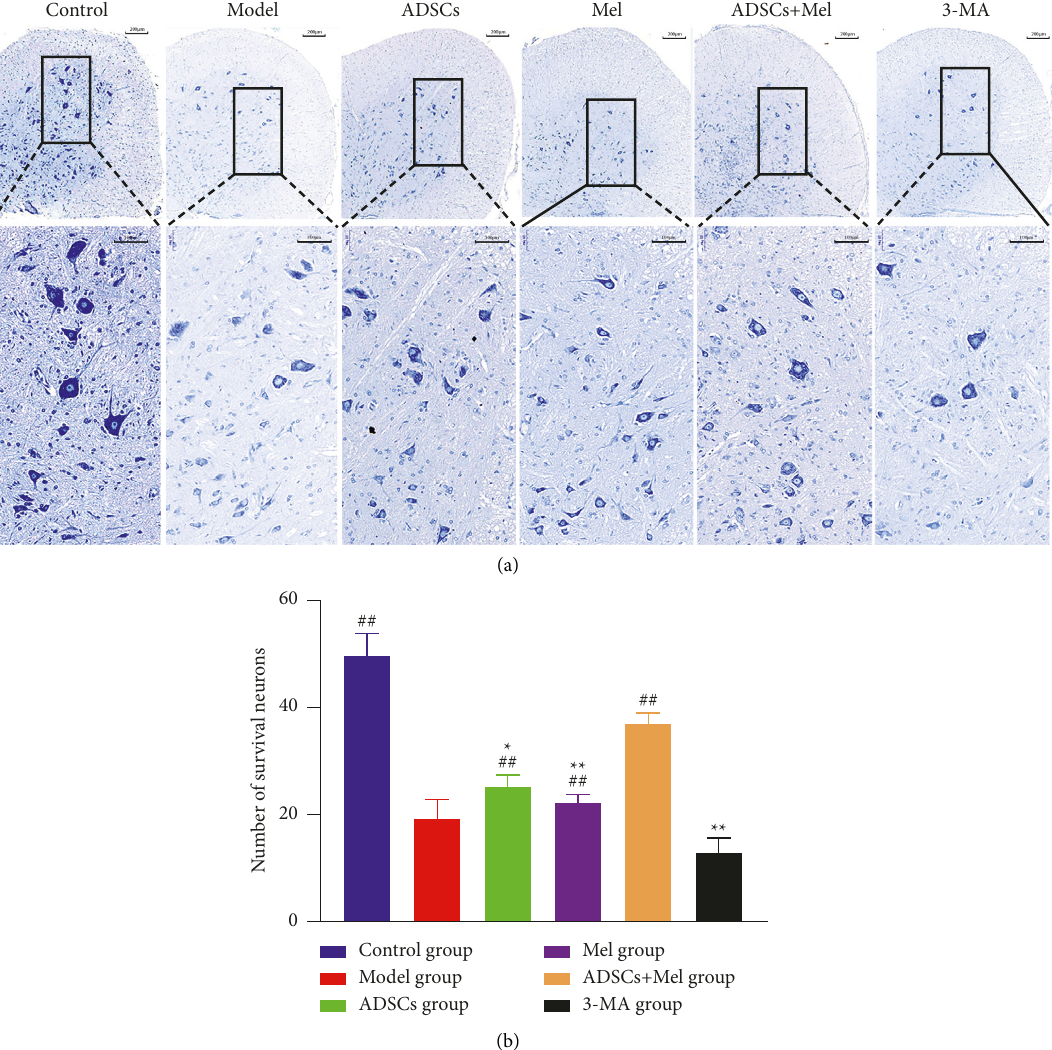
Figure 12: Histological assessment of the spinal cord. (a) L4 ventral horn Nissl staining. (b) The number of Nissl bodies in each group. Each value is the mean SE of five independent determinations. ## P ADSCs+Mel ±